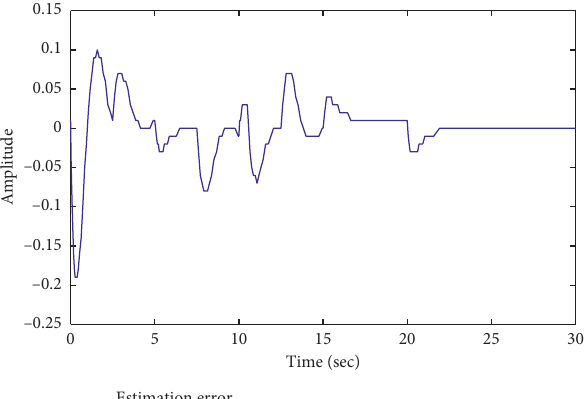
Figure 7: Response of the estimation error for